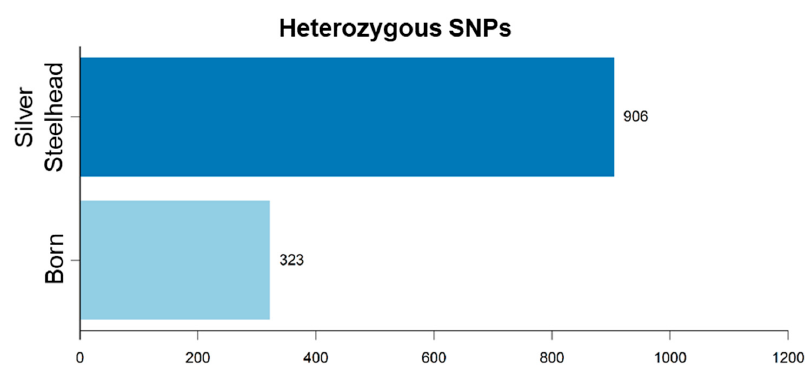
Figure 3. Number of heterozygous single nucleotide polymorphisms (SNPs) between the Silver Steelhead strain (dark blue) and the Born strain (light blue) over all tissues and individuals.